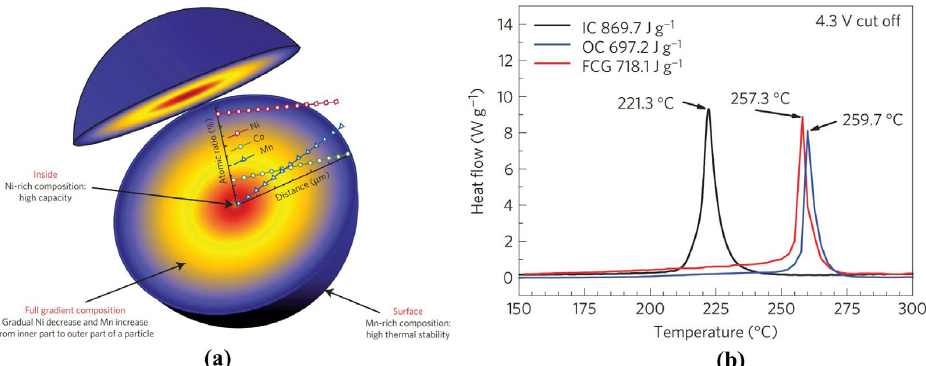
Figure 6. (a) Schematic diagram of the FCG lithium transition-metal oxide particle; and (b) DSC profiles of the delithiated FCG material, the delithiated inner composition (IC, Li 1-x Ni 0.86 Co 0.10 Mn 0.04 O 2 ) and the delithiated outer composition (Li 1 − x Ni 0.70 Co 0.10 Mn 0.2 O 2 ) with a scanning rate of 1 °C min − 1 after charging to 4.3 V. [110].